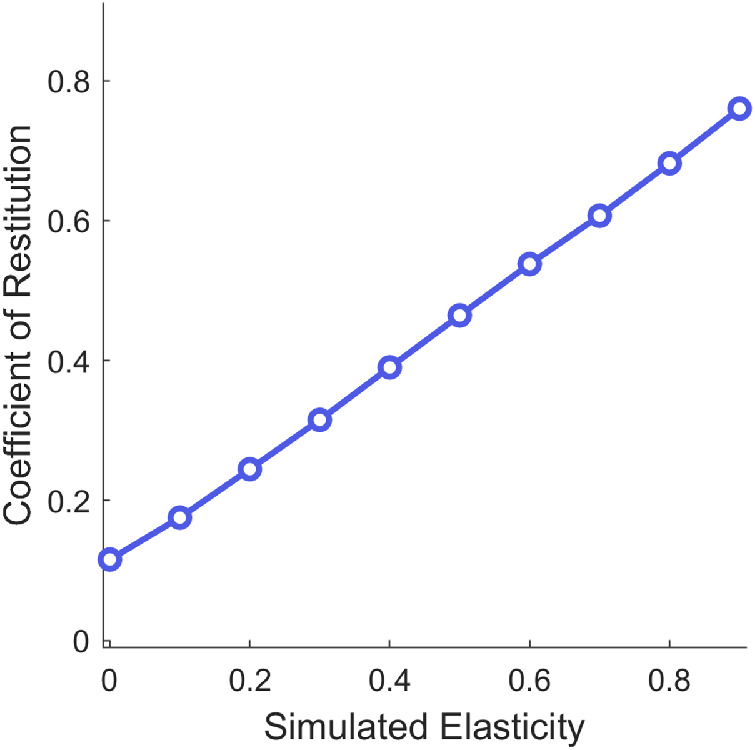
The coefficient of restitution (bounce height/drop height) for spheres of different elasticity (as defined by RealFlow's elasticity parameter).